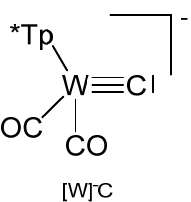
Figure 31. The [W] − C core. T* = tris(3,5-dimethylpyrazolyl)borate, [HB(pzMe 2 ) 3 ] − Figure 31. The [W] - C core. T* = tris(3,5-dimethylpyrazolyl)borate, [HB(pzMe 2 ) 3 ] − .